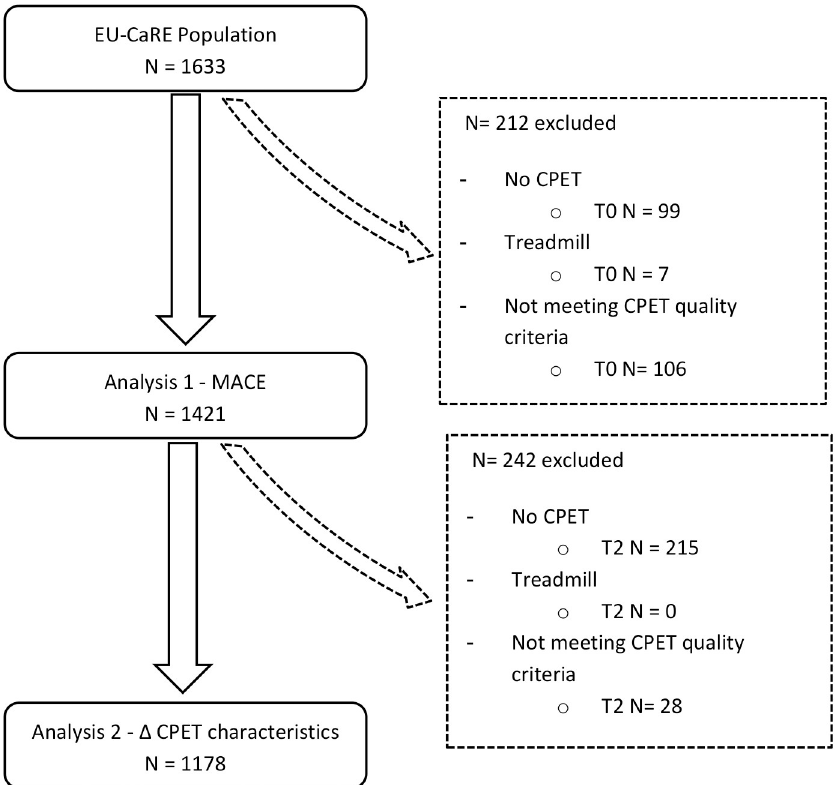
Fig 1. Flow-chart of the patients included for the analyses of MACE and changes in CPET characteristics. T0, start of CR; T2, 1-year follow-up.